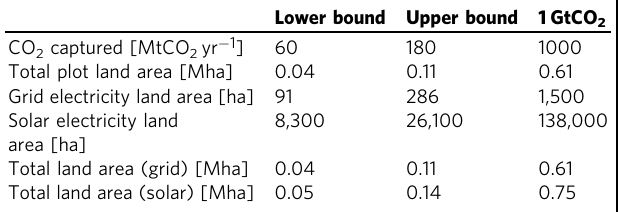
Table 6 Land area requirements for the MgO looping process.